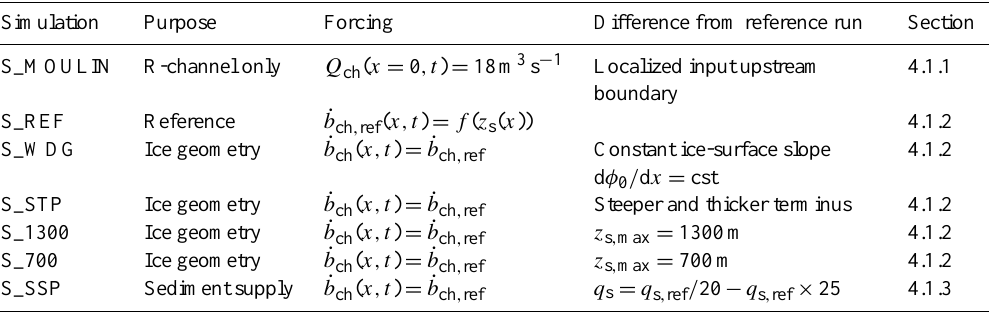
= 910kgm − 3 . The reference sediment supply used for i